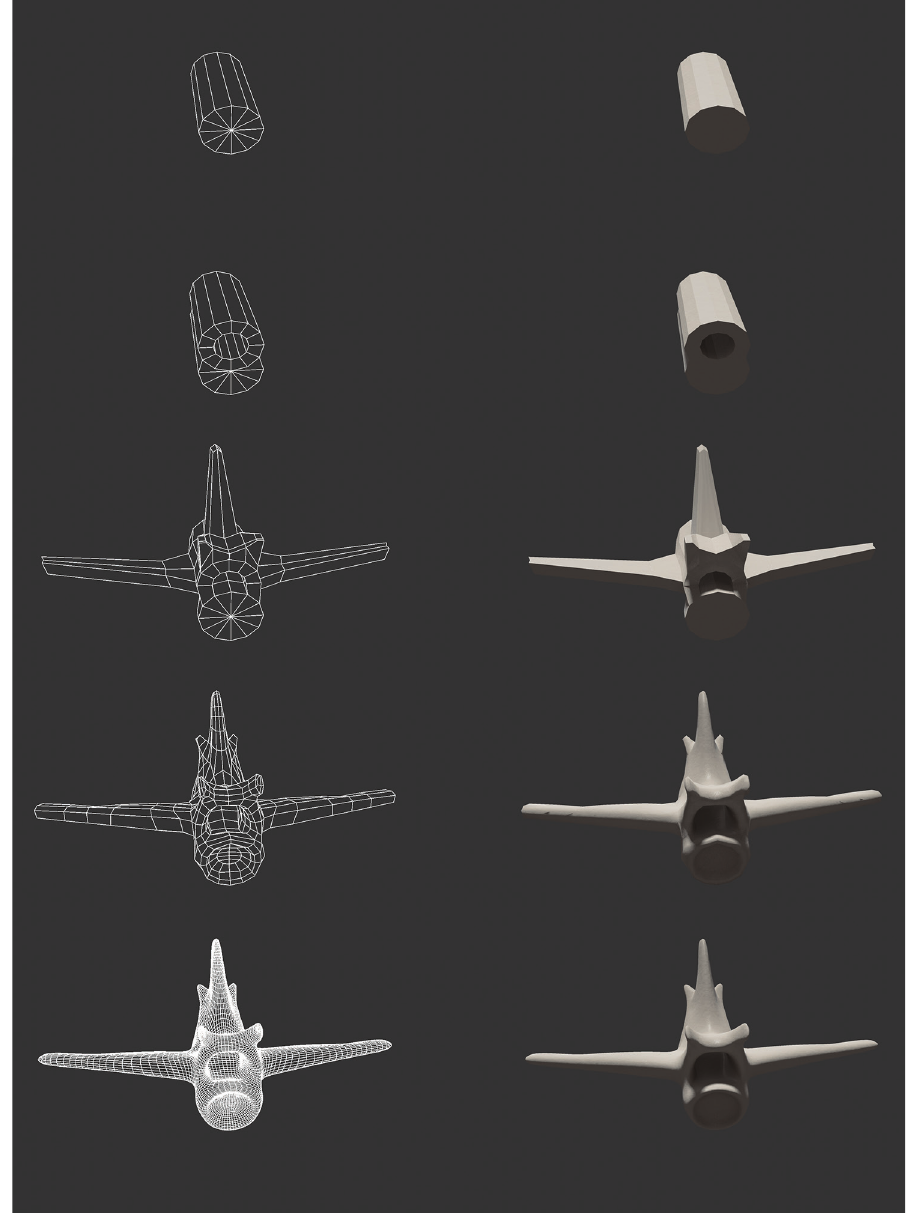
Figure 2 - Sequence of progress in the modeling process. The column on the left presents the polygonal grid visualization and the column on the right presents the solid